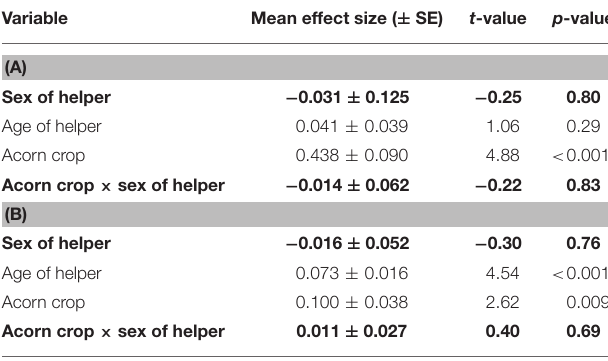
FIGURE 1 | Graphical representation of the interaction between (Top) the prior autumn’s acorn crop and the effect size of helper males on reproductive success of the group and (Bottom) the prior autumn’s acorn crop and the effect size of helper females on reproductive success of the group. Both are based on linear regressions including group composition, territory quality, prior group history as main factors. Curved lines depict 95% confidence intervals. N = 38 years.